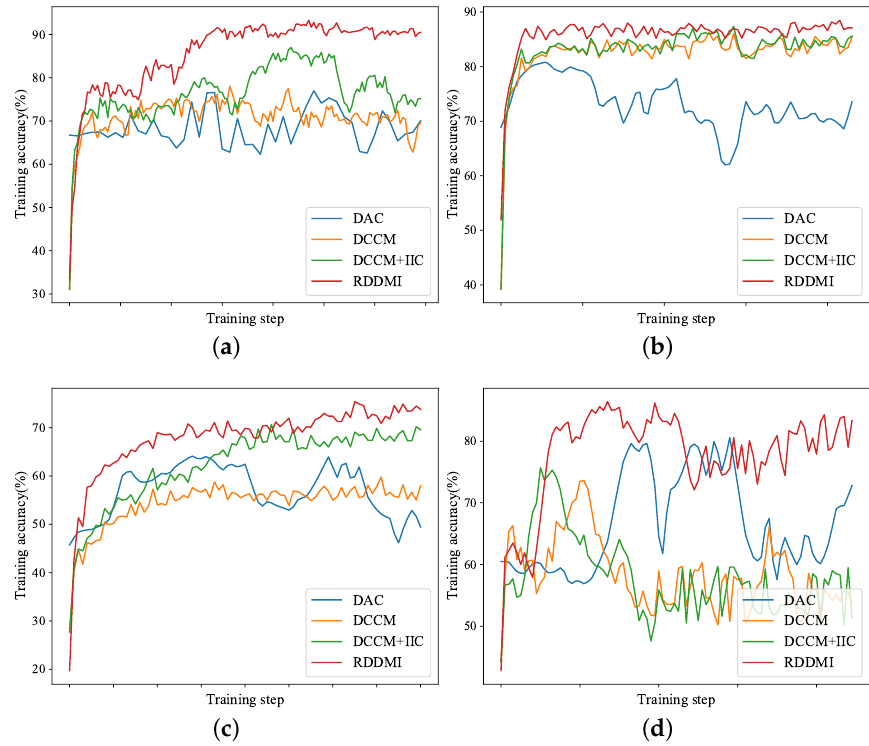
Figure 13. The training process of the four datasets. ( a ) GF-3 Wuhan; ( b ) RS-2 Flevoland; ( c ) AIRSAR Flevoland; ( d ) RS-2